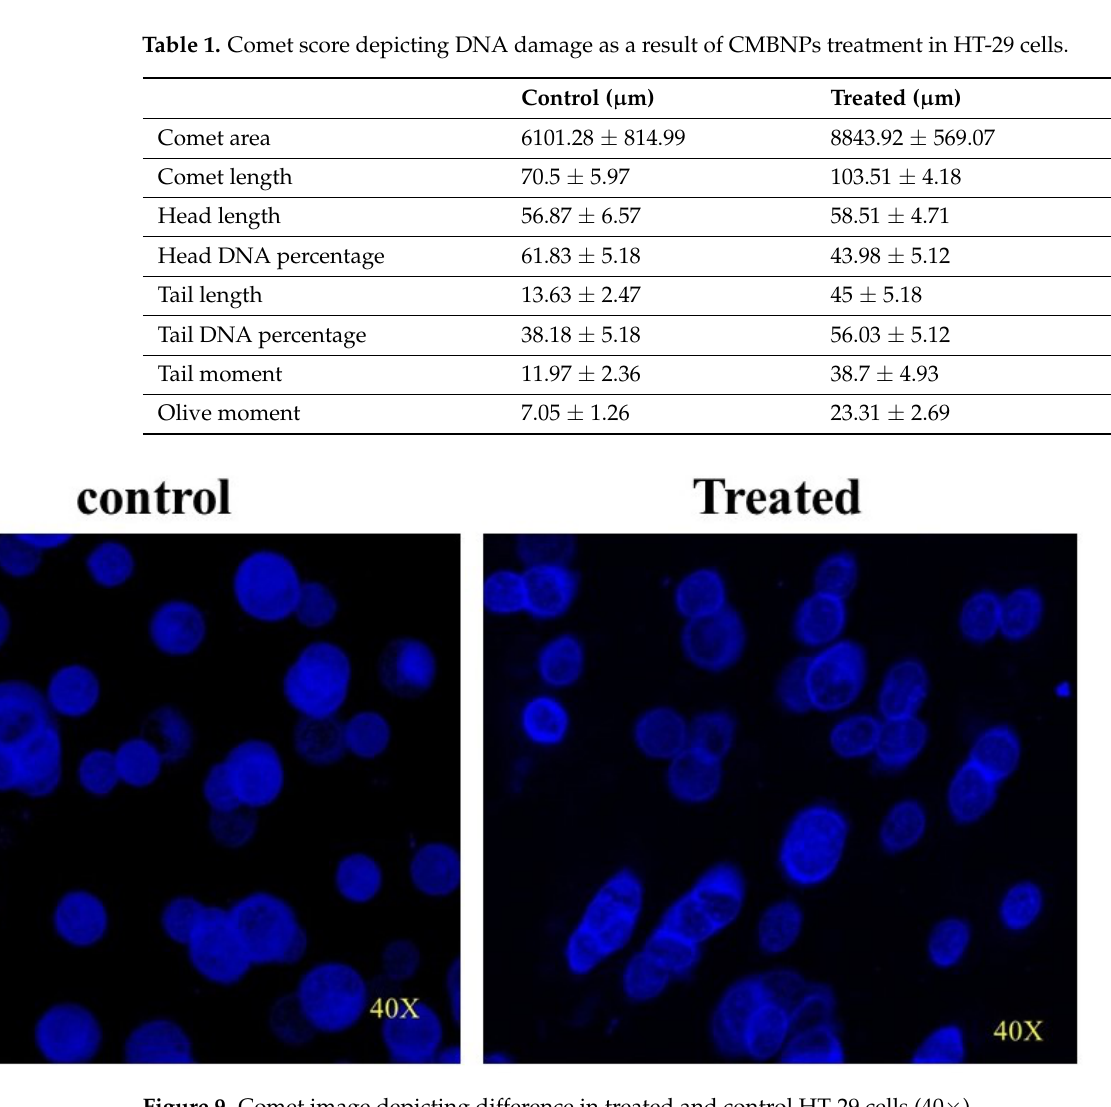
Figure 9. Comet image depicting difference in treated and control HT-29 cells (40 × ). A comparison Table 2 listing various bimetallic NPs and current NPs, showing their variable properties and applications. Table 2. Comparison of earlier reported bimetallic NPs and current biosynthesized bimetallic NPs.